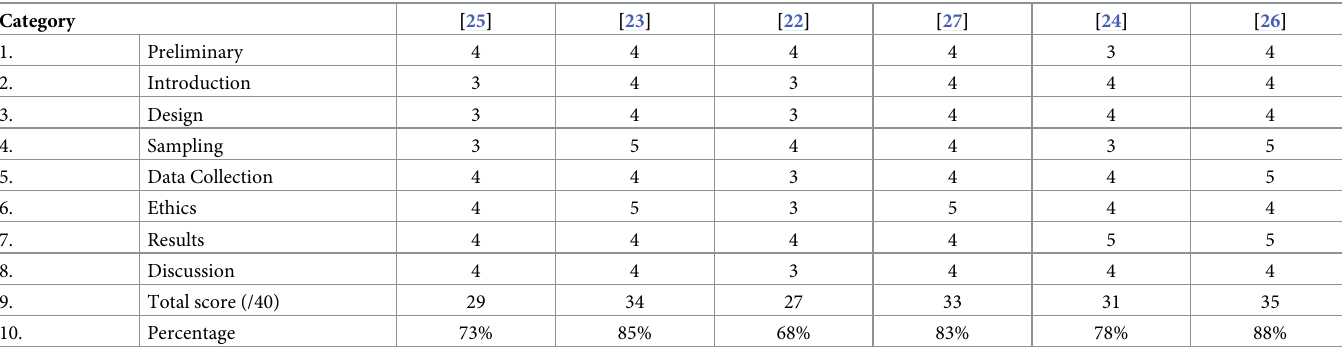
Table 1. The Crowe Critical Appraisal Tool quality assessment.